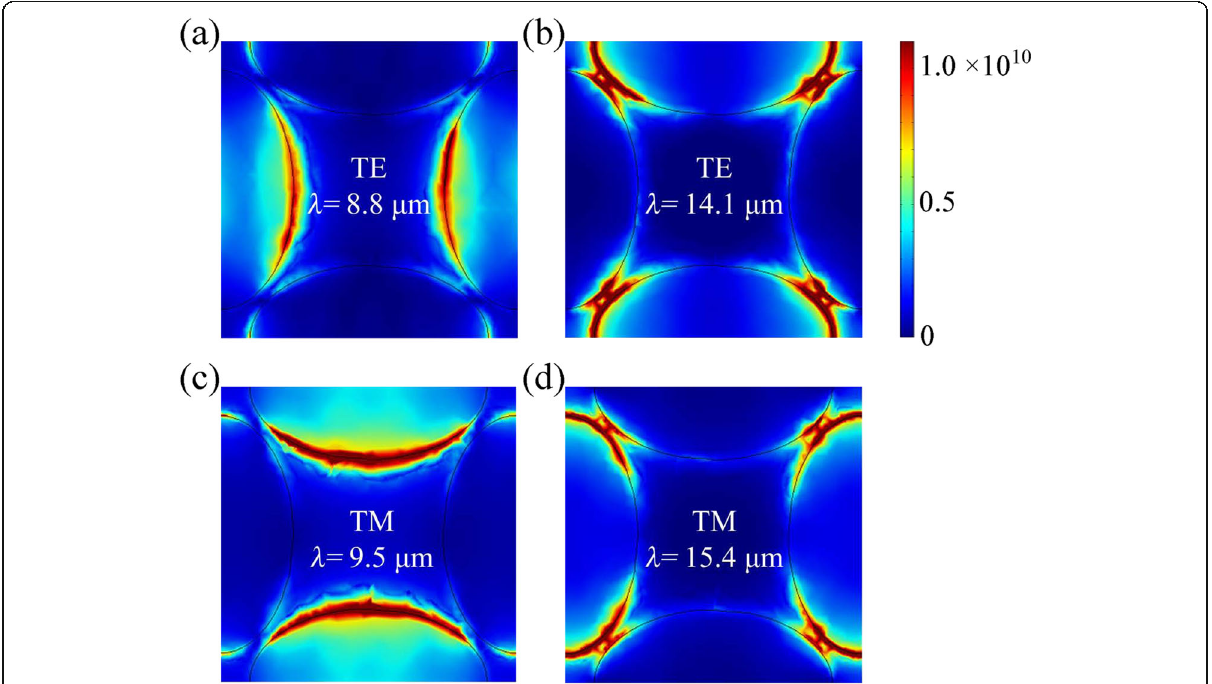
Fig. 3 Electric field intensity distributions at different wavelengths for a , b TE and c , d TM polarization, where a = 62 nm, b = 100 nm, t d = 1.35 μ m, t = 5 nm, P = 250 nm, under normal